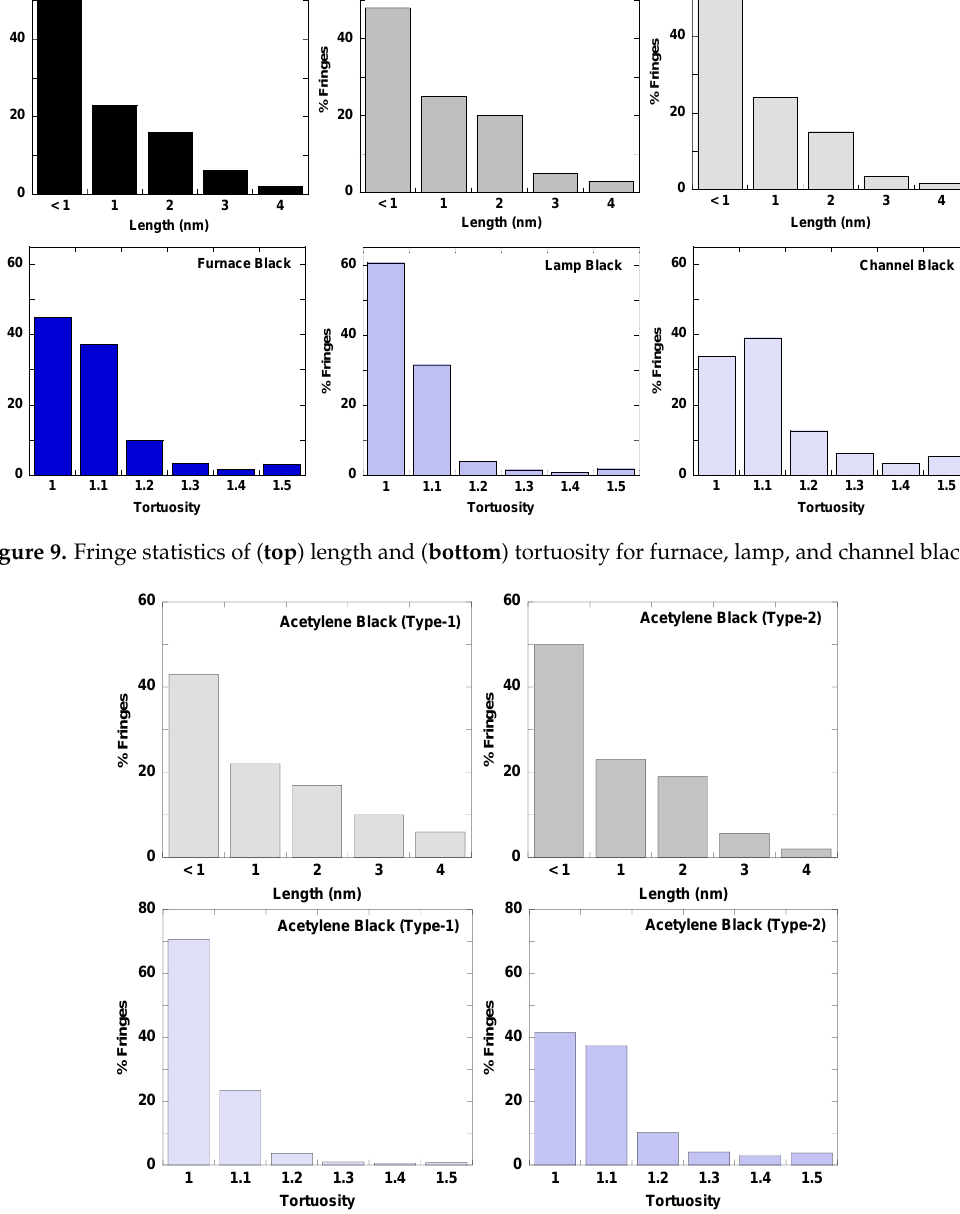
Figure 10. Fringe statistics of ( top ) length and ( bottom ) tortuosity for two acetylene blacks.